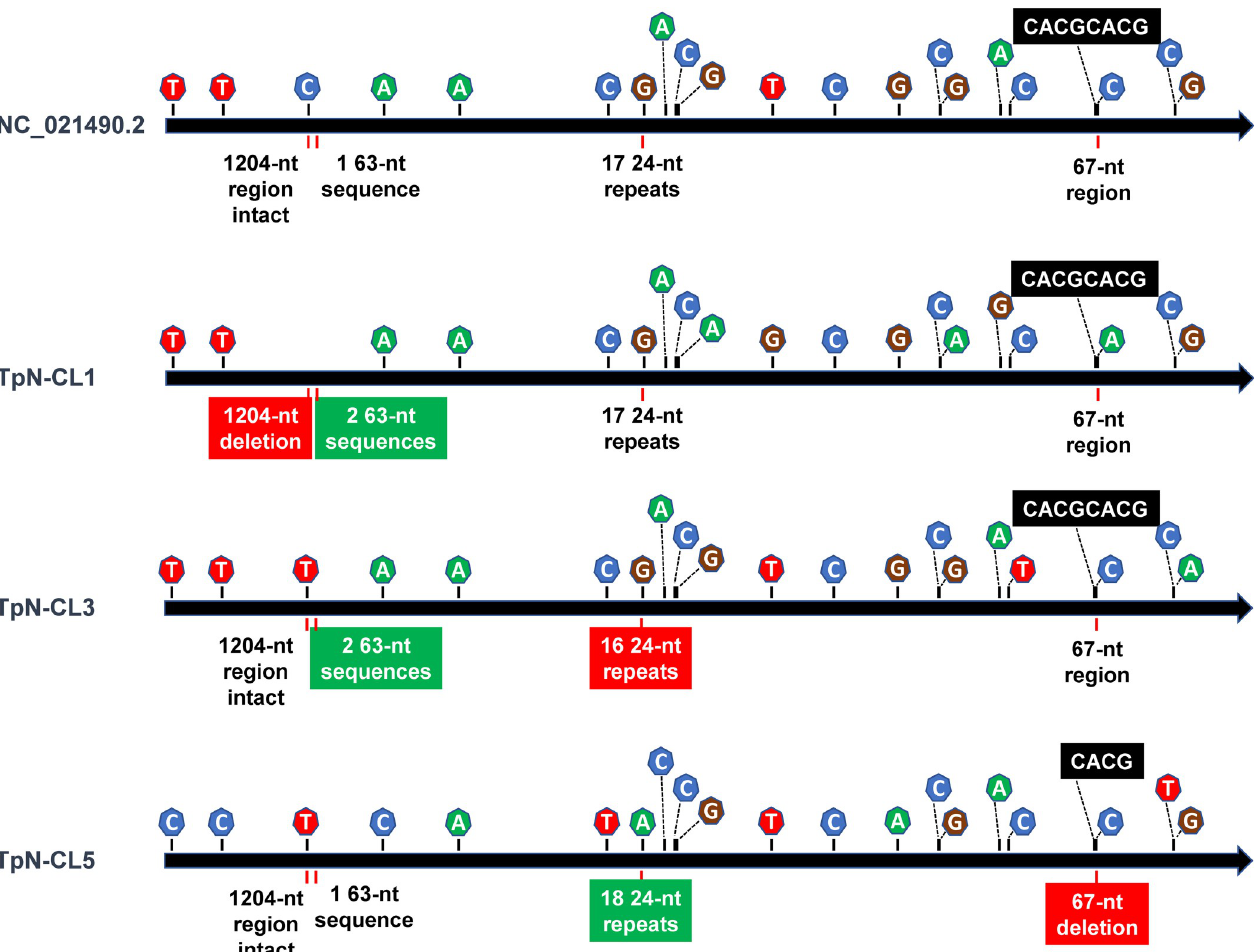
Fig 3. Heterogeneities in T . pallidum clones. Linearized map of the circular chromosome of T . pallidum Nichols reference sequence (NC_021490.2) and three representative clones, showing the locations of heterogeneities. The locations of single nucleotide variants (SNVs) and small indels are indicated above the arrow representing each genome, whereas the larger indels are shown below the arrow. The precise locations of the 20 SNVs and 5 indels are provided in Table